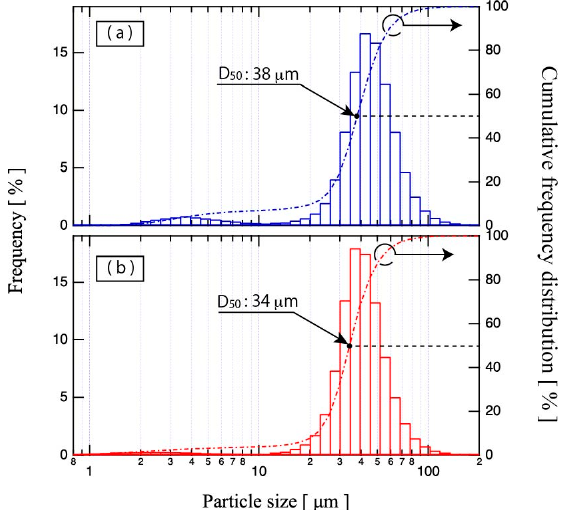
Figure 2. Morphology of WC–12%Co powders: ( a ) raw powder and ( b ) plasma-treated powder.